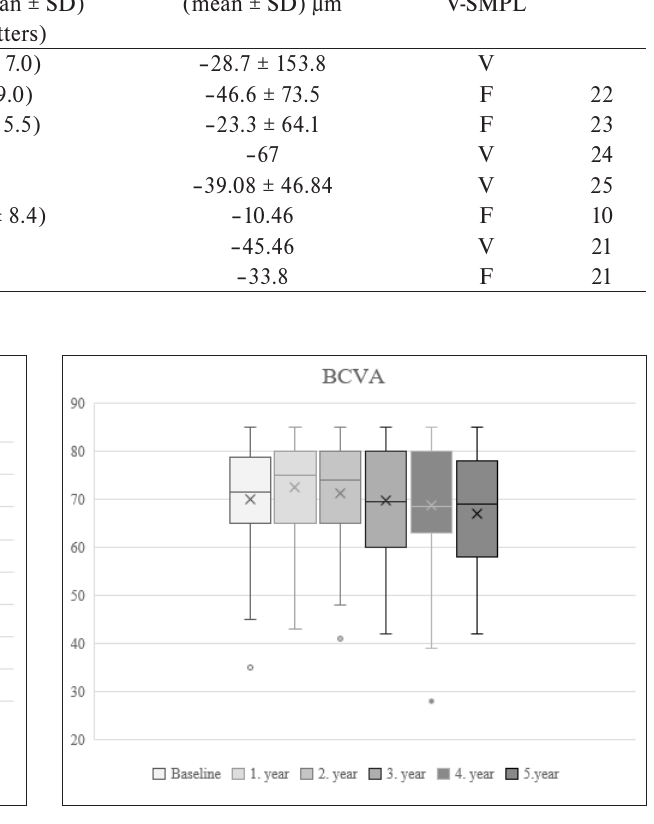
Fig. 2. Box-plots showing best corrected visual acuity (BCVA) (ETDRS letters), 5-year long